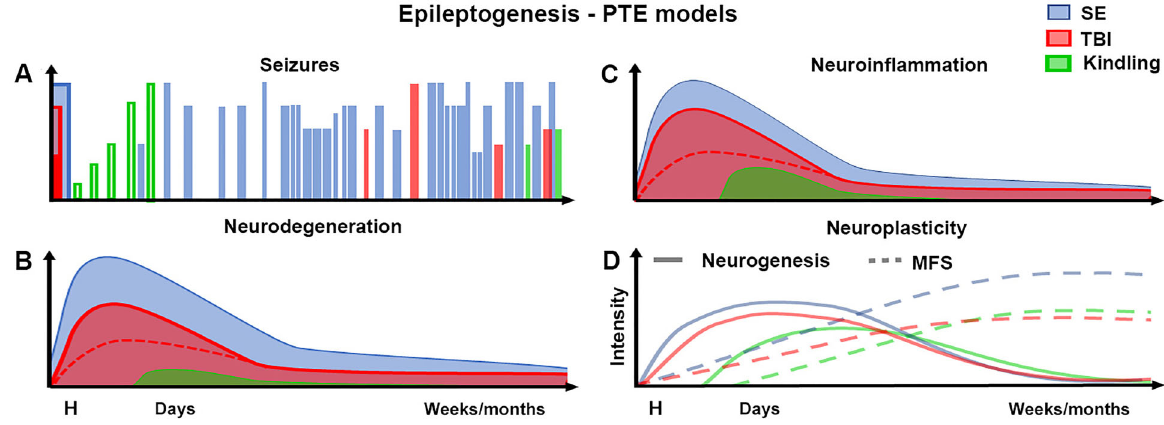
Figure 1. Schematic representation of epileptogenic features in main animal models of post-traumatic epilepsy (PTE). A , In classic models of status epilepticus (SE) (e.g., pilocarpine and kainic acid), after the initial sustained acute seizure, the development